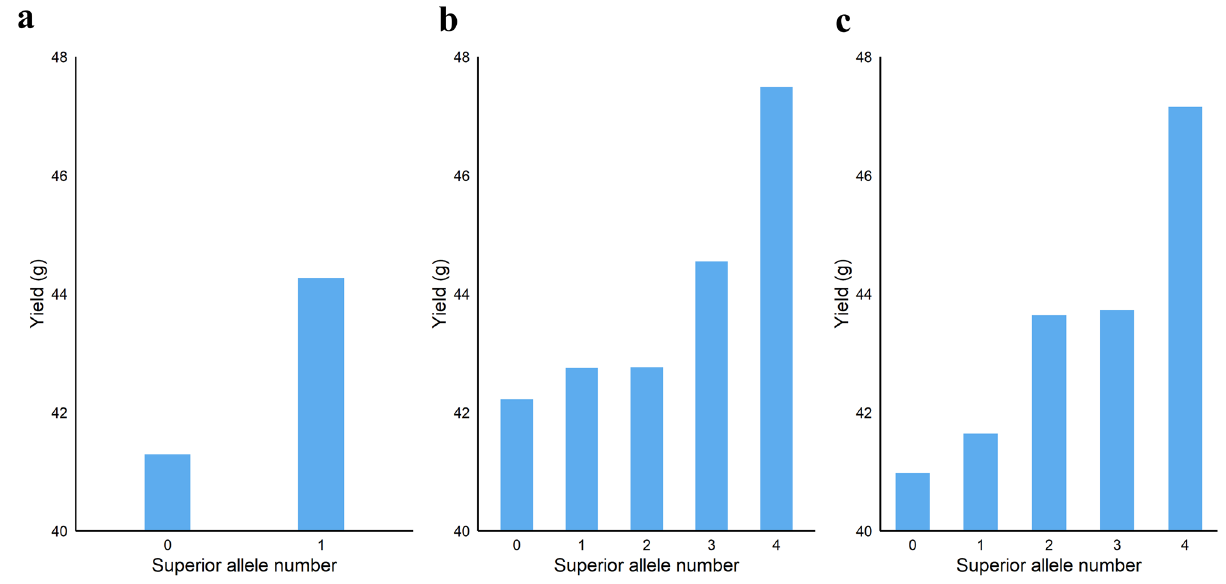
Figure 4. The average yield performance of F 1 lines with different superior allele number of significant loci. ( a ) Direct loci, ( b ) Indirect loci, ( c ) Direct plus indirect